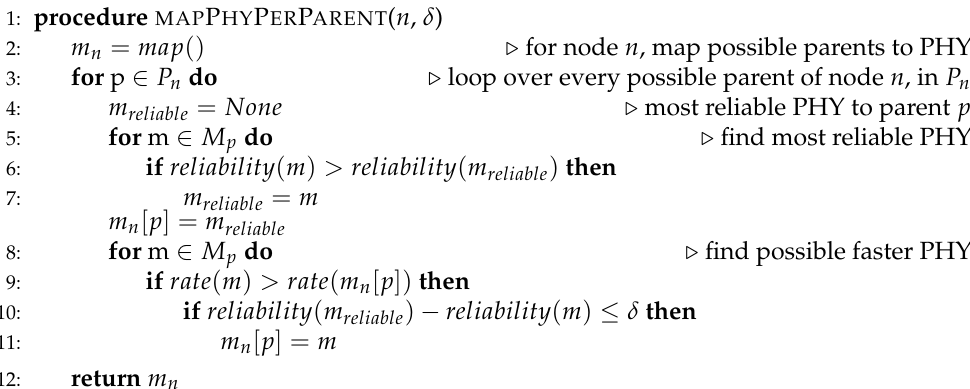
Algorithm 1 Procedure to determine the preferred PHY per possible